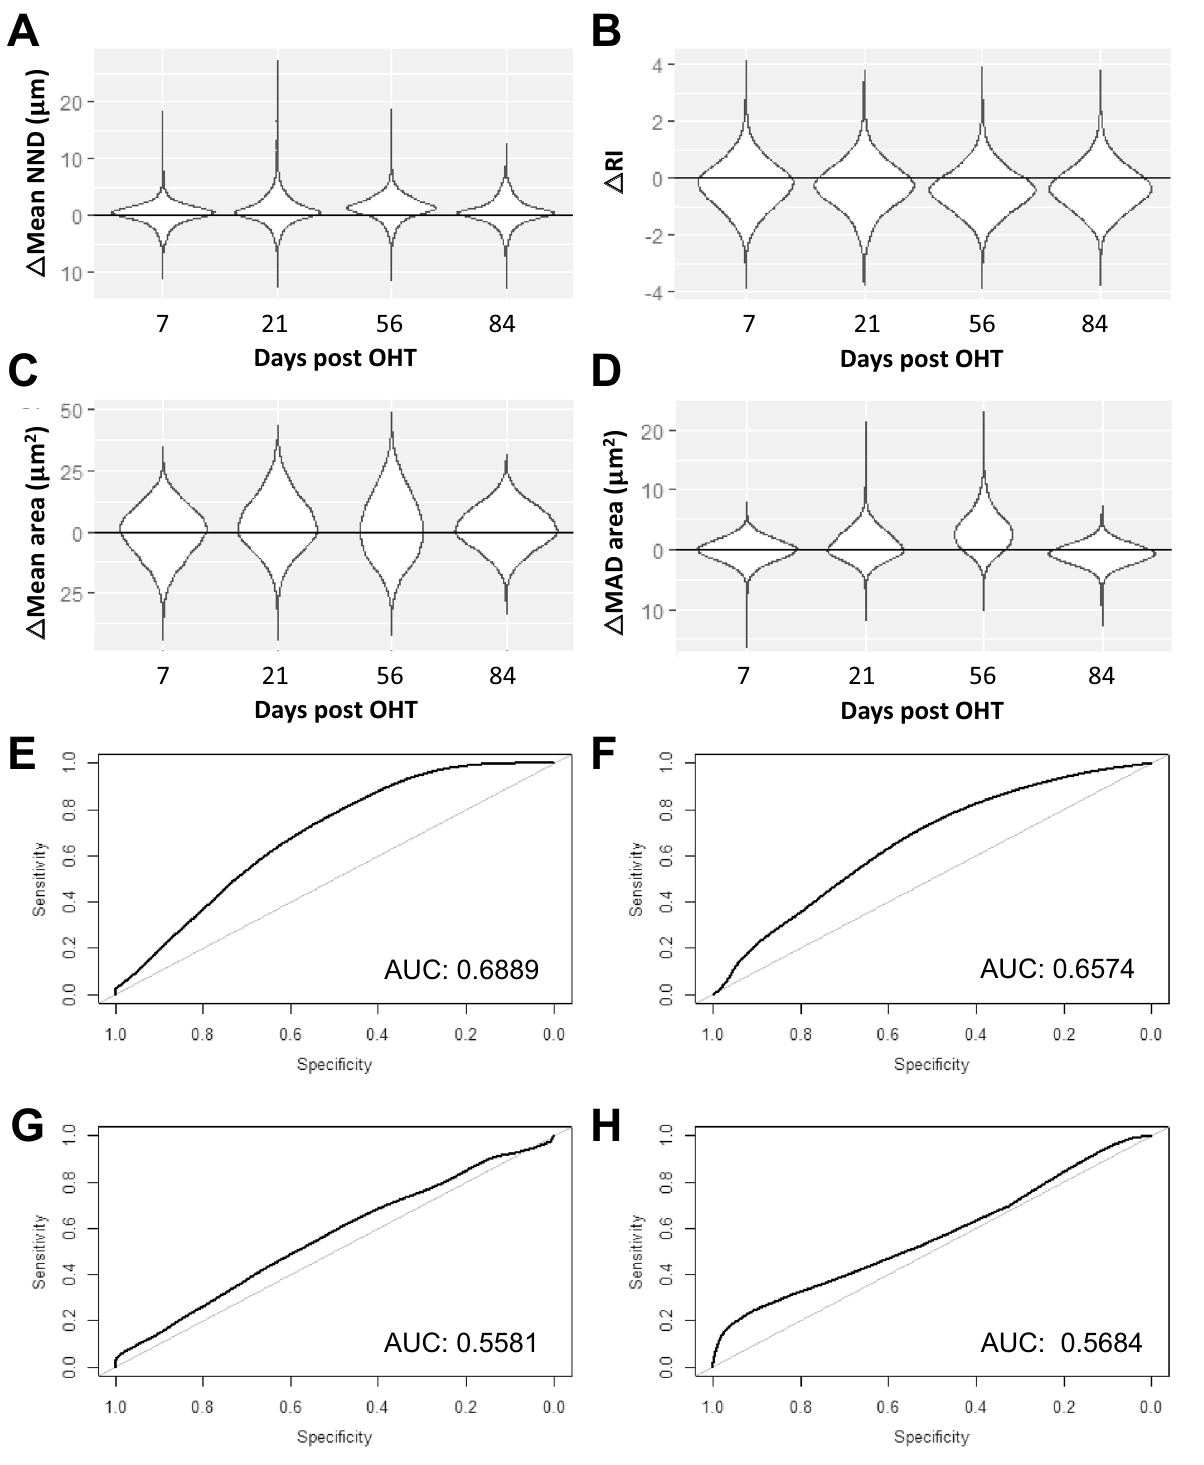
Figure 6. Determination of the diagnostic utility of subsampling the RGC population in the OHT model using a Spatial Bootstrapping versus naive controls. ( A – D ) Difference between OHT and Naive retina randomly subsampled 100 000 times as described in the text and corresponding ROC curves ( E – H ). Results compared include ( A , E ) Nearest Neighbour Distance (NND), ( B , F ) Regularity Index (RI), ( C , G ) Mean RGC size and Mean absolute deviation in RGC size ( D , H ). A table with the median and 95% confidence intervals for the bootstrapping results has been added in supplement (Suppl. Table